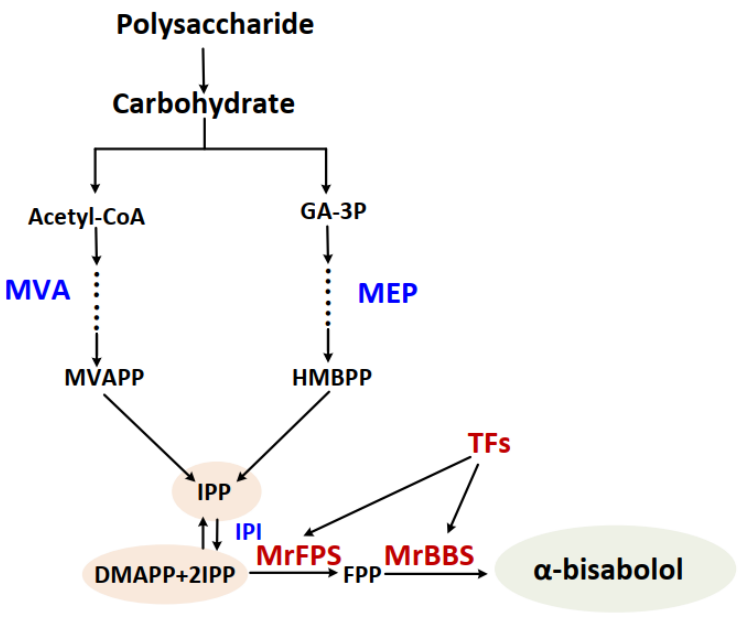
Figure 9. The biosynthesis pathway of α -bisabolol in German chamomile. We identified genes associated with FPS and BBS in German chamomile and cloned them; the ORFs of MrFPS and MrBBS were 1032 and 1719 bp, respectively, and encode